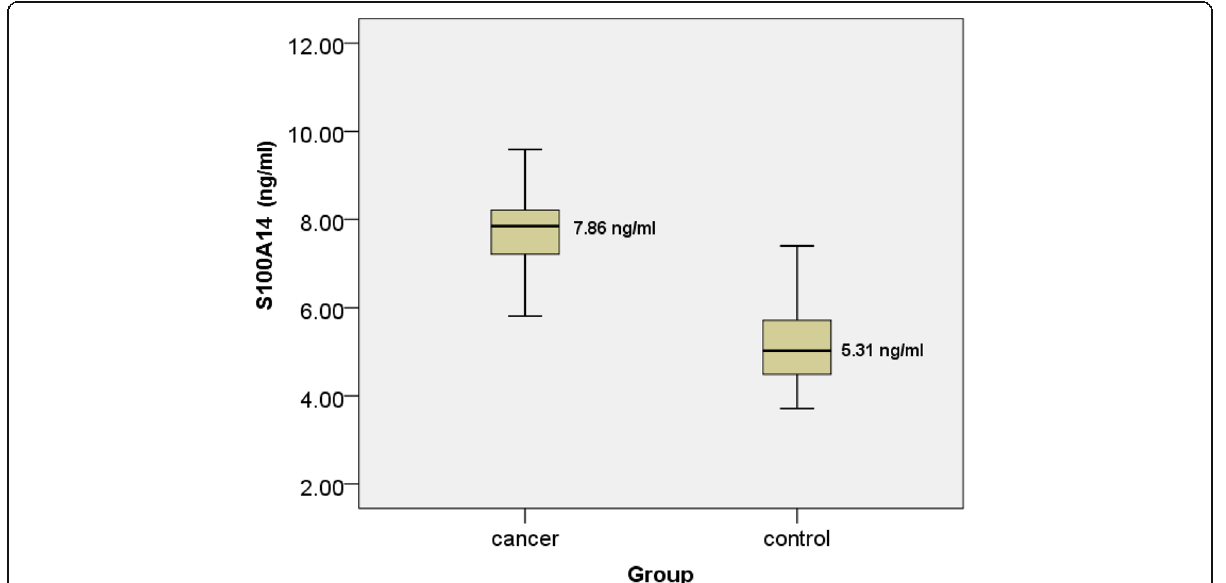
Fig. 1 S100A14 serum levels in control group ( n = 22) and cancer group ( n =